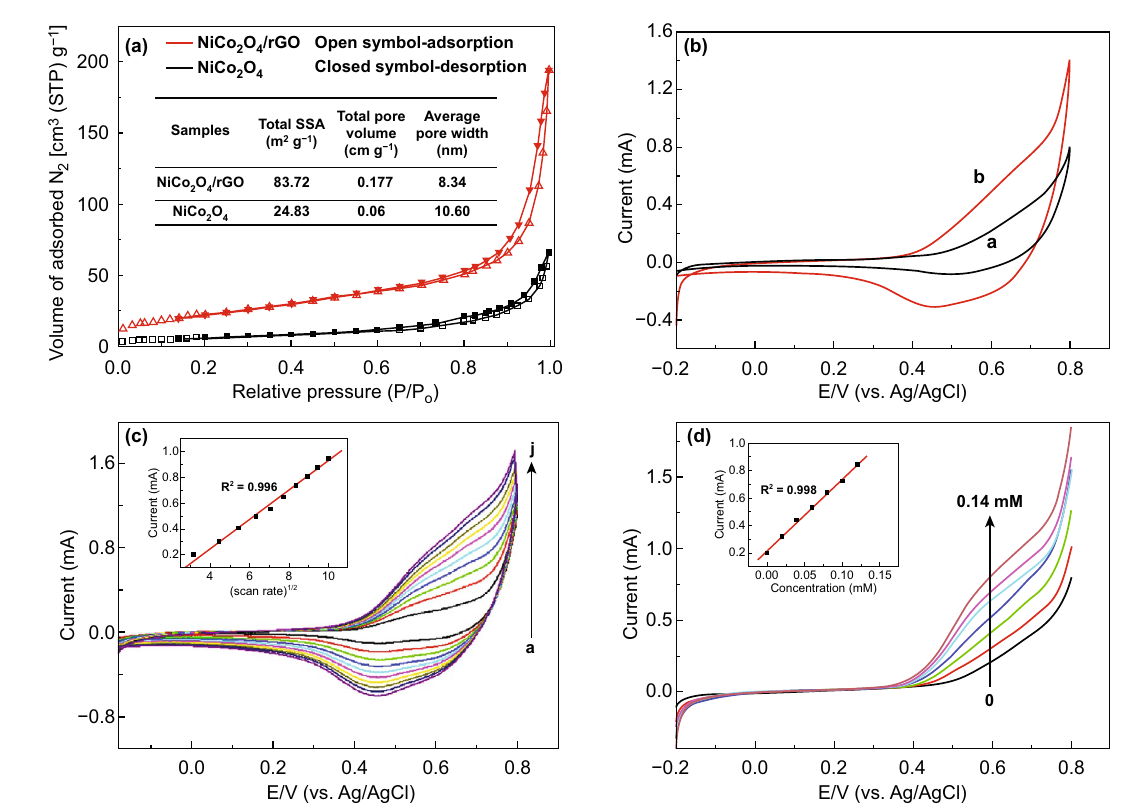
Fig. 26 a Adsorption–desorption hysteresis loop, specific surface area (SSA), average pore width, and total pore volume of the synthesized pure NiCo 2 O 4 and NiCo 2 O 4 /graphene nanohybrids. b CV for NiCo 2 O 4 /graphene hybrid-modified electrode. c Effect of scan rates scan rate for the solution with 0.1 mM glucose in 0.1 M NaOH. d Linear sweep voltammetric curves for glucose in the concentration of 0–0.14 mM and calibra- tion plot (Inset). Reproduced with permission from Ref. [244]. Copyright © 2016 Elsevier